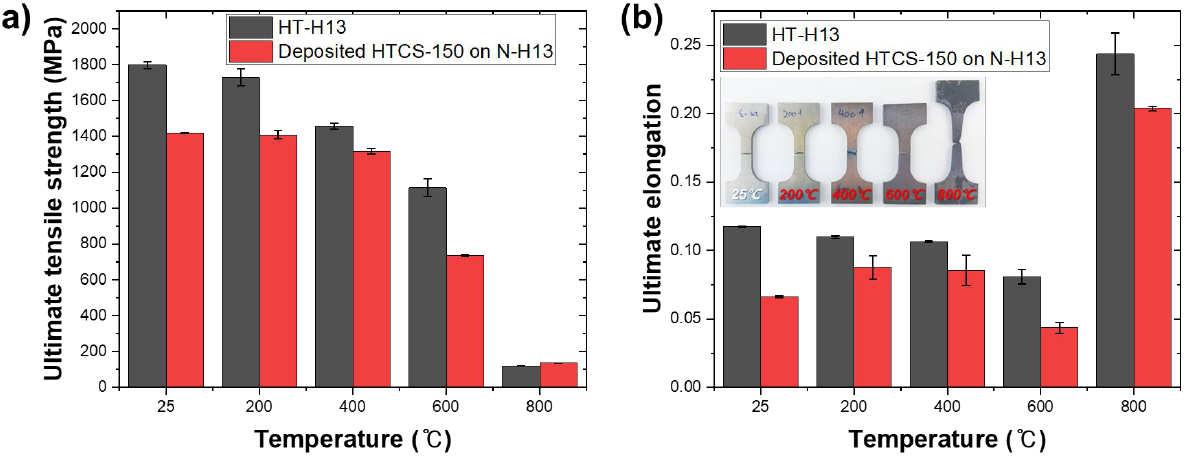
Figure 9. Bar graphs of ( a ) ultimate tensile strength and ( b ) ultimate elongation of the HTCS-150 deposited on N-H13, compared to HT-H13, at elevated deposited on N-H13, compared to HT-H13, at elevated temperatures.